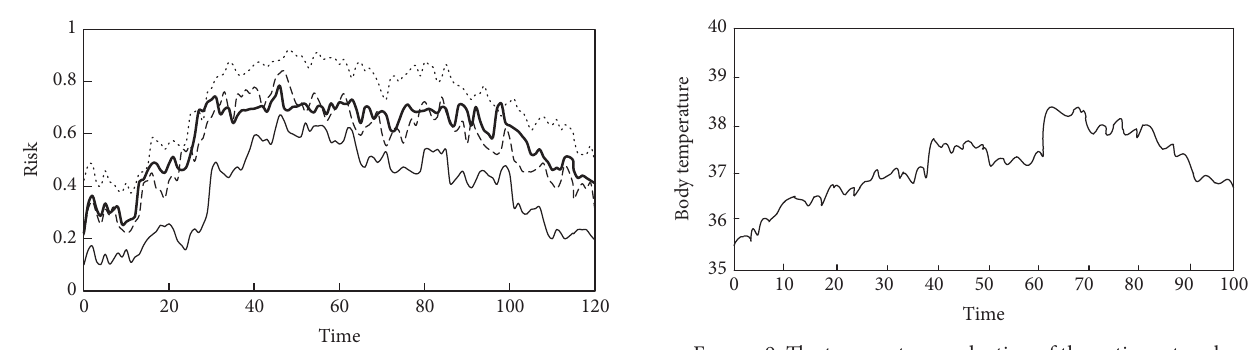
Figure 9: The temperature evaluation of the entire network.